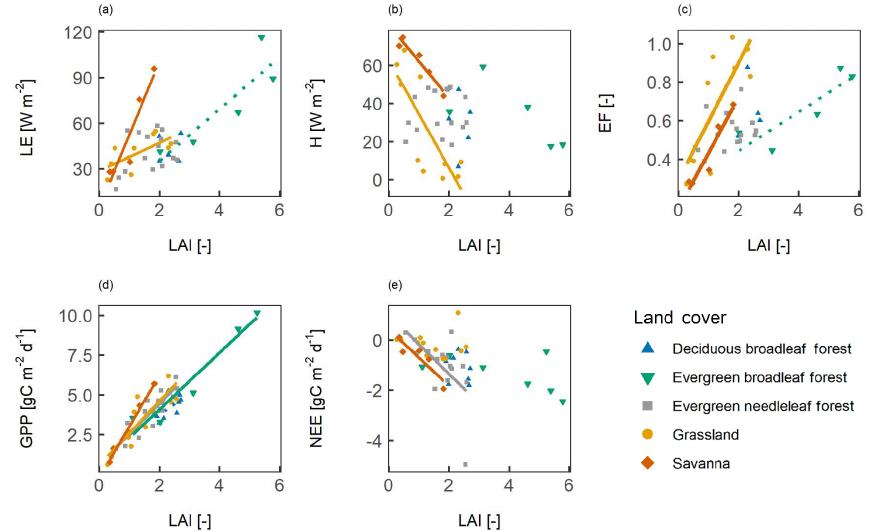
Figure 5. The spatial correlation between surface fluxes and the leaf area index (LAI). Panels show (a) the latent heat flux ( LE ), (b) the sensible heat flux ( H ), (c) the evaporative fraction (EF), (d) gross primary productivity (GPP), and (e) net ecosystem exchange (NEE). All sites are included that have at least 3 years of LAI and flux data available. A line indicates a significant correlation at p< 0 . 05, and a dashed line indicates a significant correlation at p< 0 .